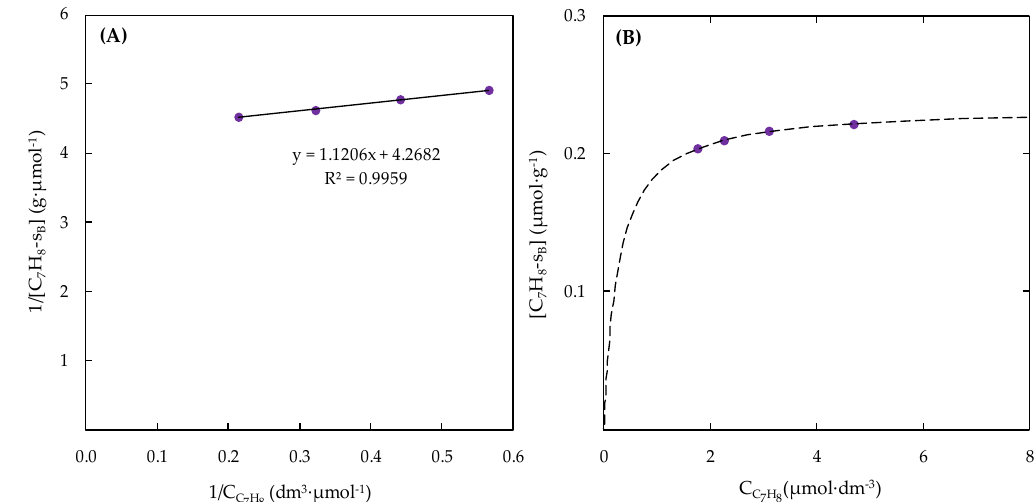
Figure 3. Adsorption equilibrium data of toluene at 293 K over acidic transformed natural zeolite: ( A ) linearized form of Langmuir adsorption model from Equation (22). ( B ) Langmuir adsorption model using Equation (22). ( • ) stands for experimental q values calculated from Equation (3); ( − ) represents linearized form of Langmuir adsorption model; (- -) stands for Langmuir adsorption